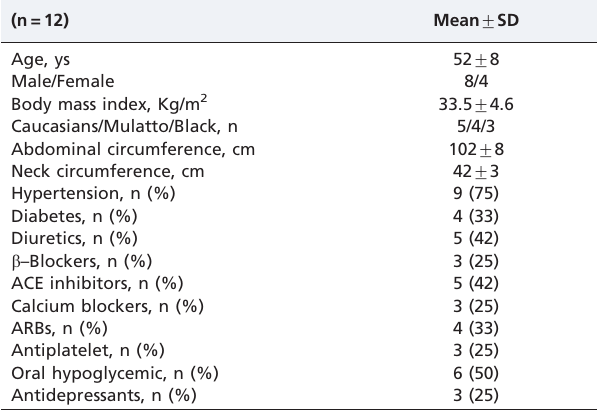
Table 1 - The demographic and clinical characteristics of the patients.